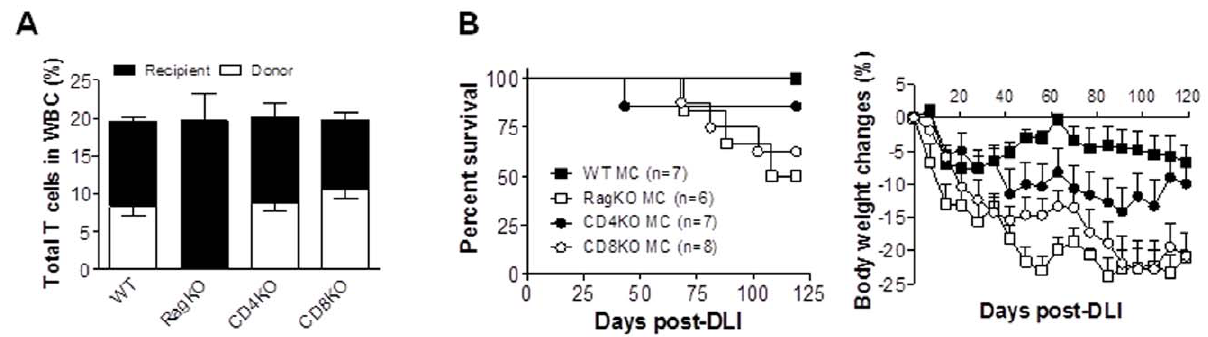
Figure 3. Both donor BM-derived CD4 and CD8 T cells are protective against GVHD in mixed chimeras receiving delayed DLI. Lethally (8 Gy) irradiated BALB/c mice were reconstituted with a mixture of TCD BALB/c plus WT (WT MC; n=7), RagKO (RagKO MC; n=6), CD4KO (CD4KO MC; n=7), or CD8KO (CD8KO MC; n=8) B6 BMCs 8 weeks before DLI from WT B6 donors. (A) Hematopoietic chimerism in WBCs measI can hear Kazured one week prior to DLI. (B) Survival (left) and body weight changes (right).